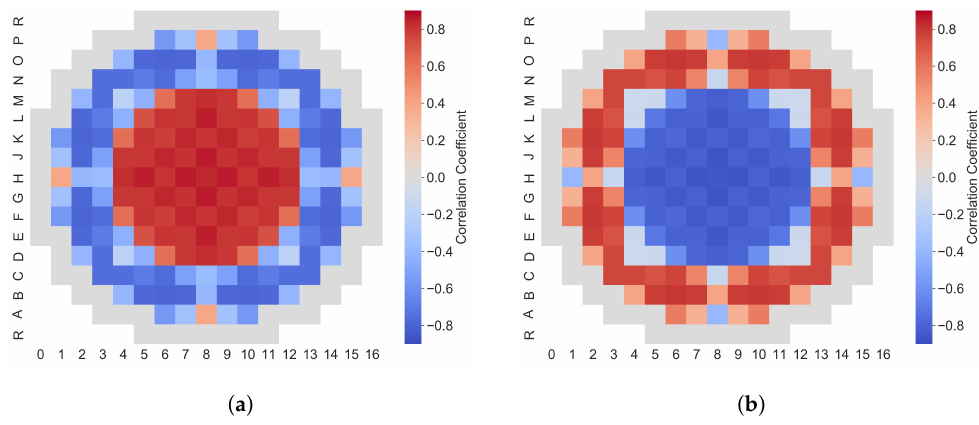
Figure 17. Radial distribution of the maximum Spearman correlation coefficient between the axially maximum linear power and ( a ) 238 U elastic scattering and ( b ) 238 U inelastic